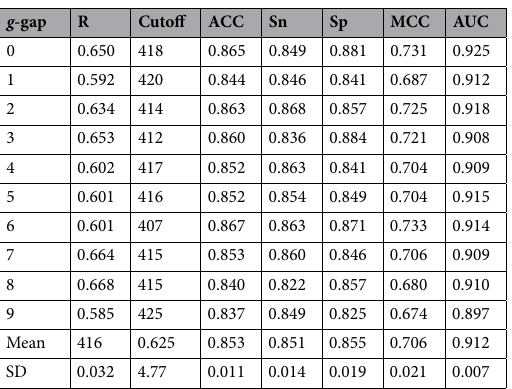
Table 3. Independent test results of SCM models using different optimal propensity scores of g -gap